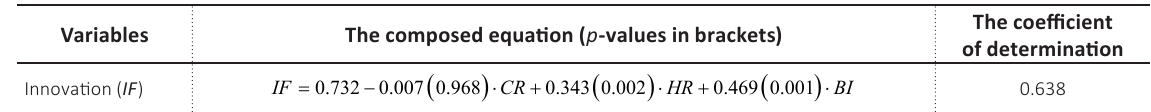
Table 3. The impact of cooperative relationships, infrastructure of business and human resources on innovation Variables The composed equation ( p -values in brackets) The coefficient